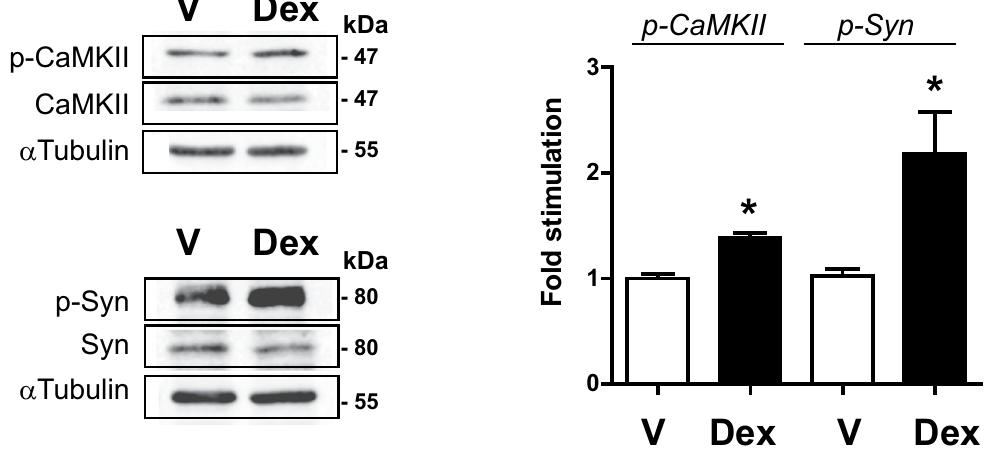
Figure 2. Dexamethasone stimulates phosphorylation of CaMKII and Syn in mouse pituitary explants. Explanted pituitaries were treated with Dex (10 − 7 M) or not (Vehicle, V) for 30 min. Lysates were subjected to immunoblotting with anti-p-CaMKII, anti-CaMKII, anti-Syn, anti-p-Syn and anti- α -tubulin antibodies. Dex induced significant increase in the phosphorylation state of CaMKII and Synapsin-I. Cropped blots (full length WBs are presented in Supplementary Fig. S4d) are shown in the figure and are representative image of 3 independent experiments. Results are expressed as means ± SEM fold stimulation when compared to vehicle. Statistical significance was assessed by One way ANOVA, Dunnett’s posttest, n = 3, * p ≤ 0.05. p-CaMKII: phospho-CaMKII; p-Syn: